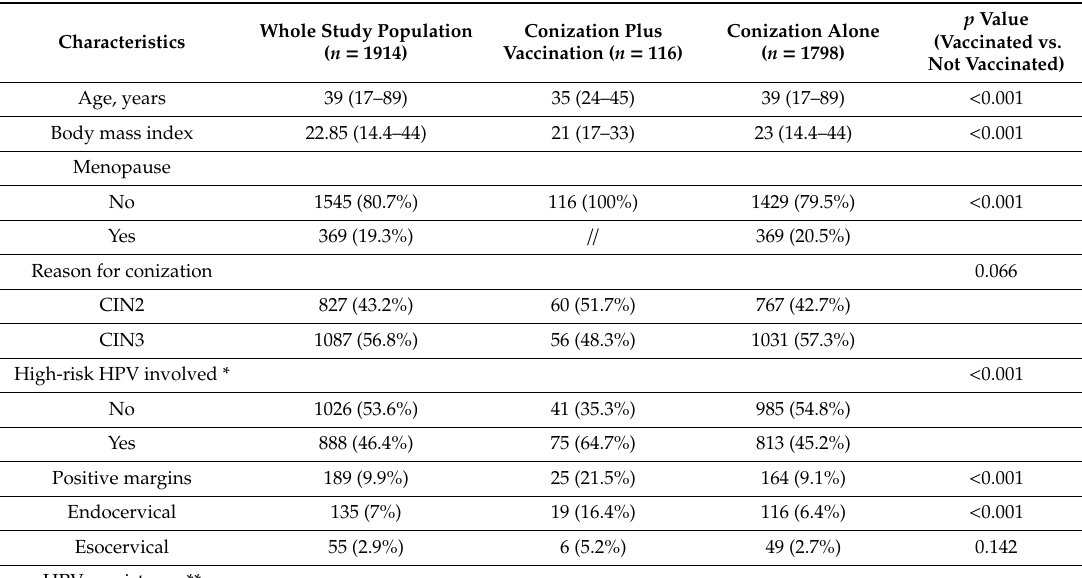
Figure 2. Five-year recurrence for women undergoing conization plus vaccination vs. conization alone ( A ) and five-year recurrence in the propensity-matched comparison cohorts ( B ).